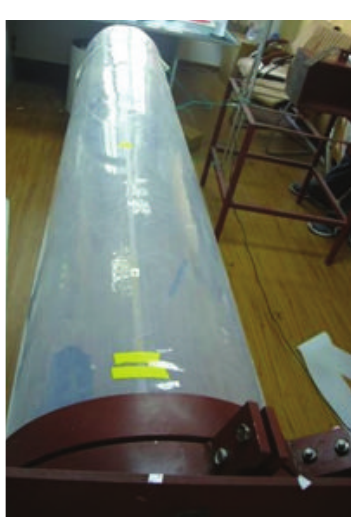
Figure 2: The test model of an ETFE inflatable tube. Figure 3: Wrinkles in wrinkled